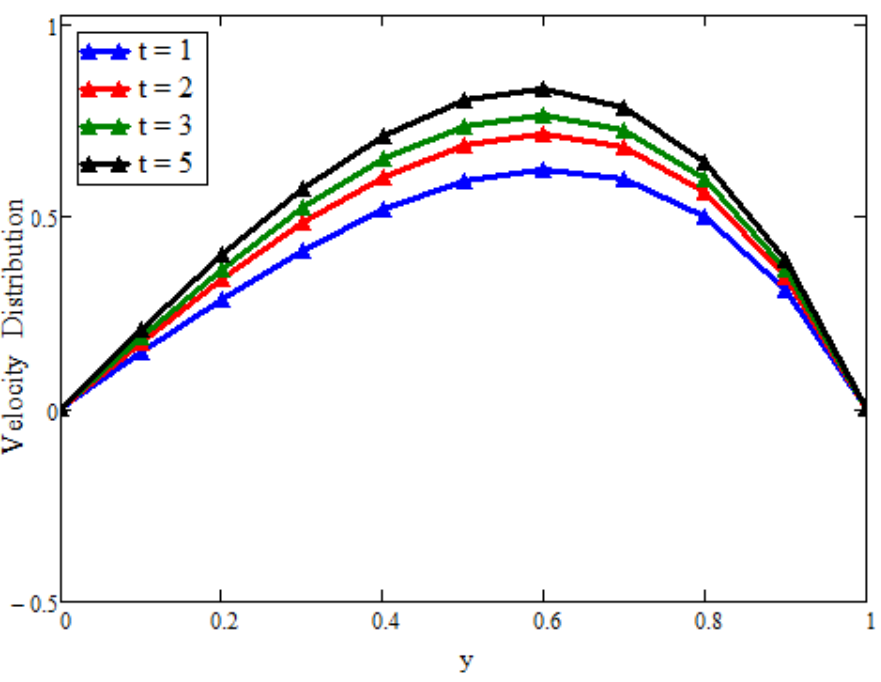
Figure 10. Temperature distribution against y due to t , when Pr = 6.2, φ hnf = 0.02, α = β = γ = 0.5.